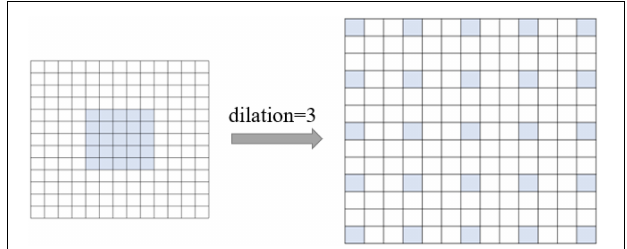
FIGURE 3 | Dilated convolution.